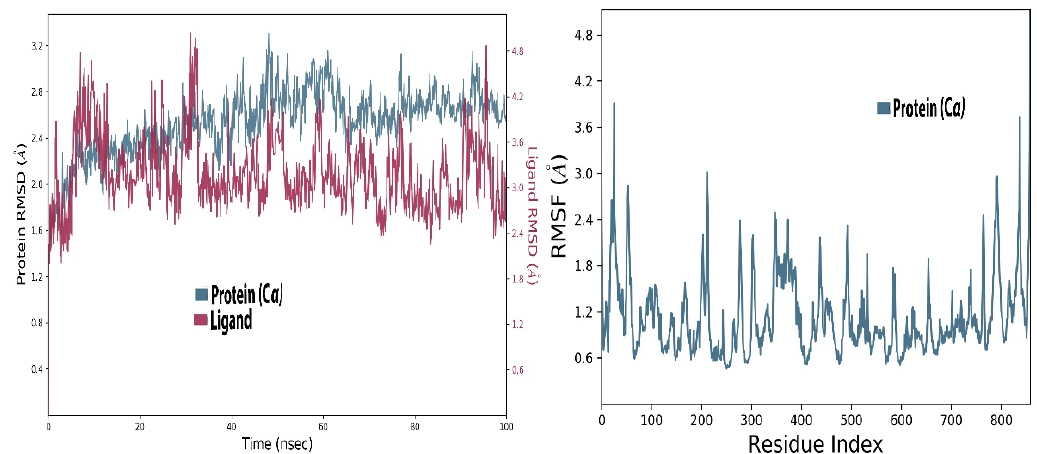
Figure 3. Root mean square deviation ( Left panel ) and root mean square fluctuation ( Right panel ) of RdR in complex with aureusidin 4,6-diglucoside.